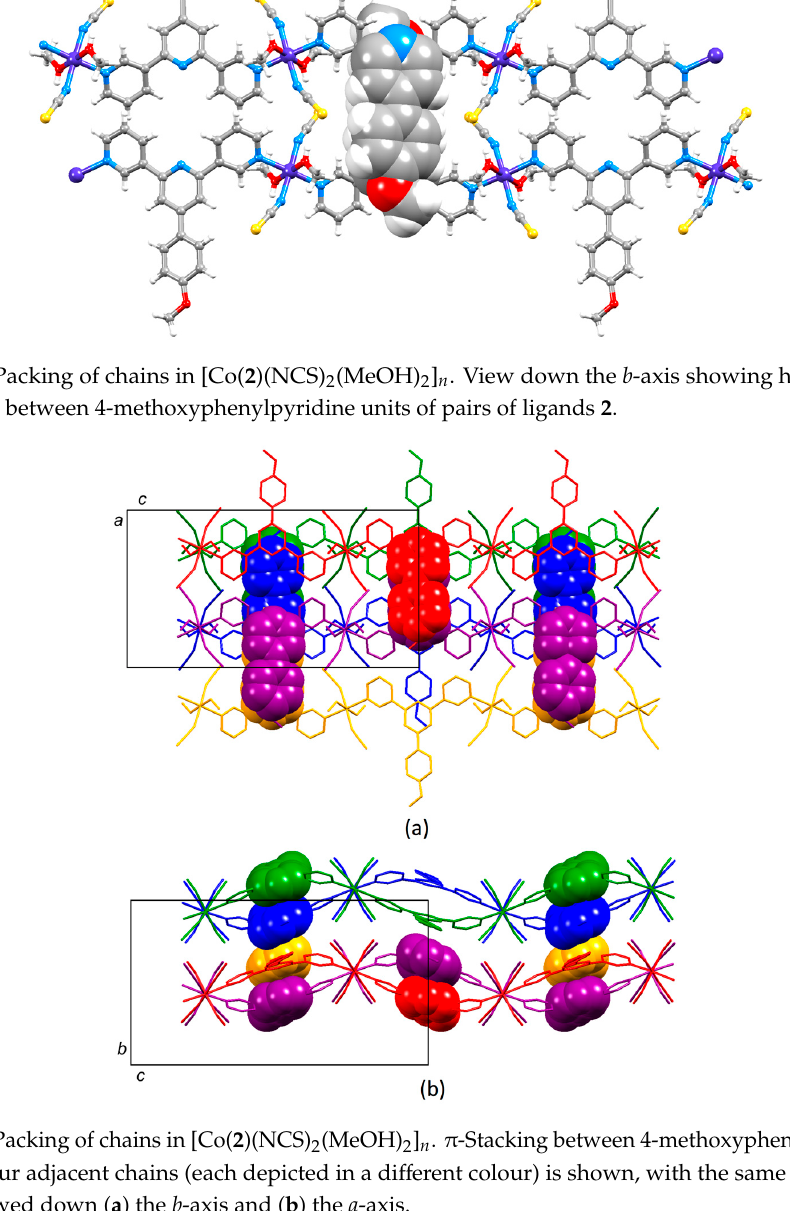
Figure 6. Packing of chains in [Co( 2 )(NCS) 2 (MeOH) 2 ] n . π -Stacking between 4-methoxyphenylpyridine Figure 6 . Packing of chains in [Co( 2 )(NCS) 2 (MeOH) 2 ] n . π -Stacking between units in four adjacent chains (each depicted in a di ff erent colour) is shown, with the same part of the 4-methoxyphenylpyridine units in four adjacent chains (each depicted in a different colour) is lattice viewed down ( a ) the b -axis and ( b ) the a shown, with the same part of the lattice viewed down ( a ) the b -axis and ( b ) the a -axis.